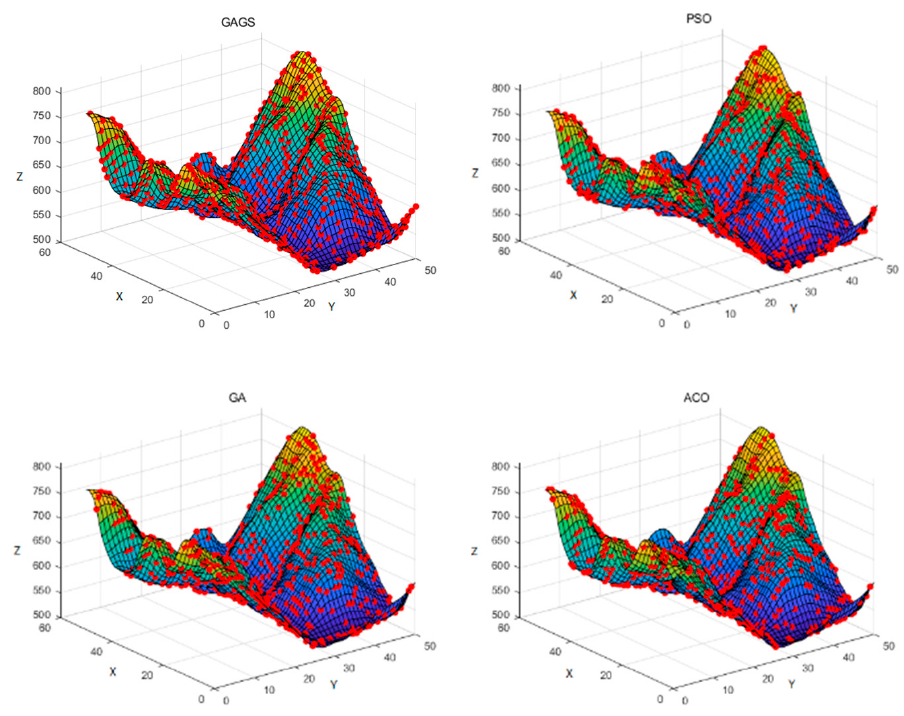
Figure 11. Node deployment after increasing the coverage model attenuation factor.